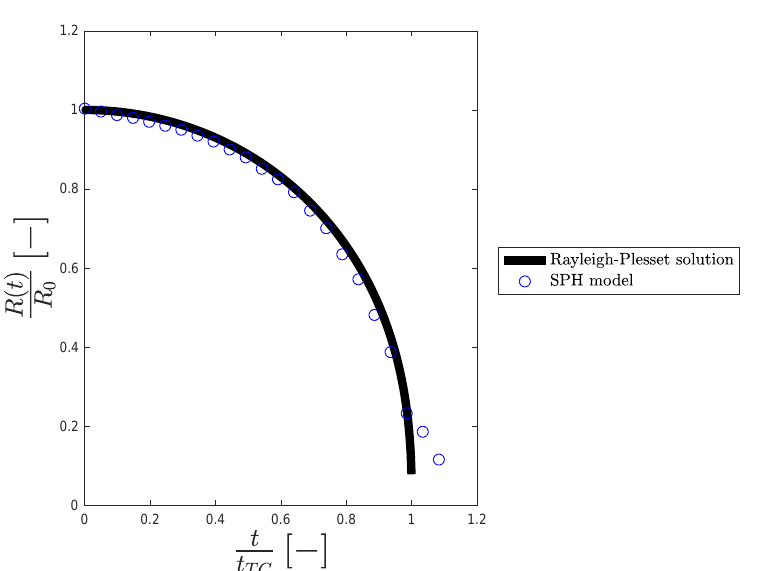
Figure 2. Dimensionless ratio ( R / R 0 ) against dimensionless time ( t / t c ) for both SPH (blue circle dot) and the numerical solution of the Rayleigh-Plesset equation (continuum black curve) for the empty cavity collapse ( P ∞ = 50 [MPa], ρ L =1000 [Kg m − 3 ] , P b = 0, ρ b = 0).